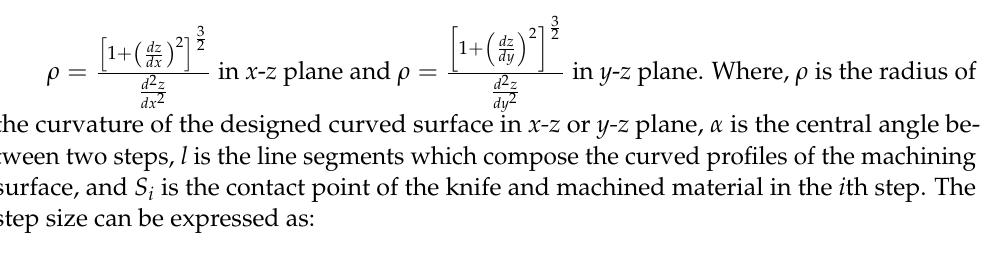
in y - z plane. Where, ρ is the radius of